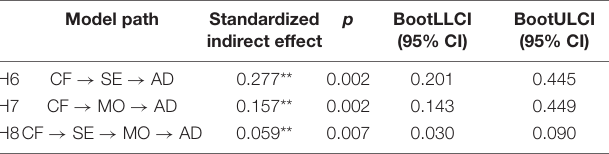
TABLE 7 | Bootstrap analysis of mediating effect significance test for the final